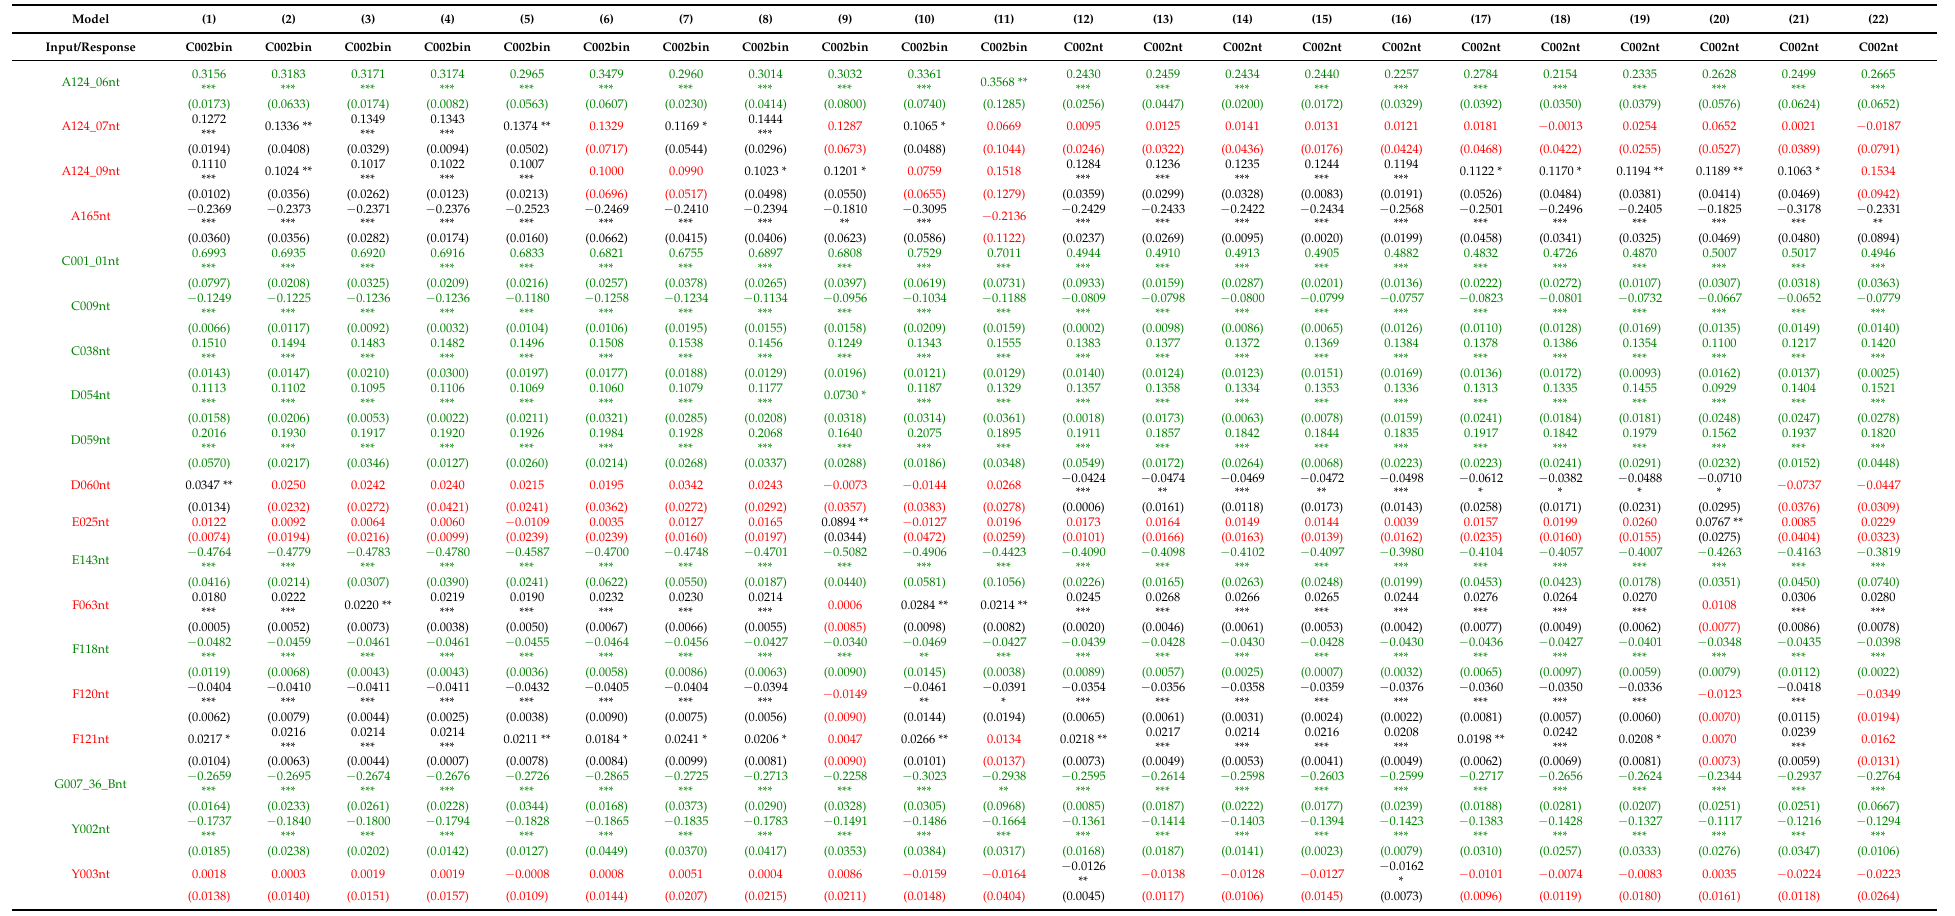
Table A3. The results of cross-validations on some socio-demographic variables using mixed-effects binary (first 11 models) and ordered logit (last 11